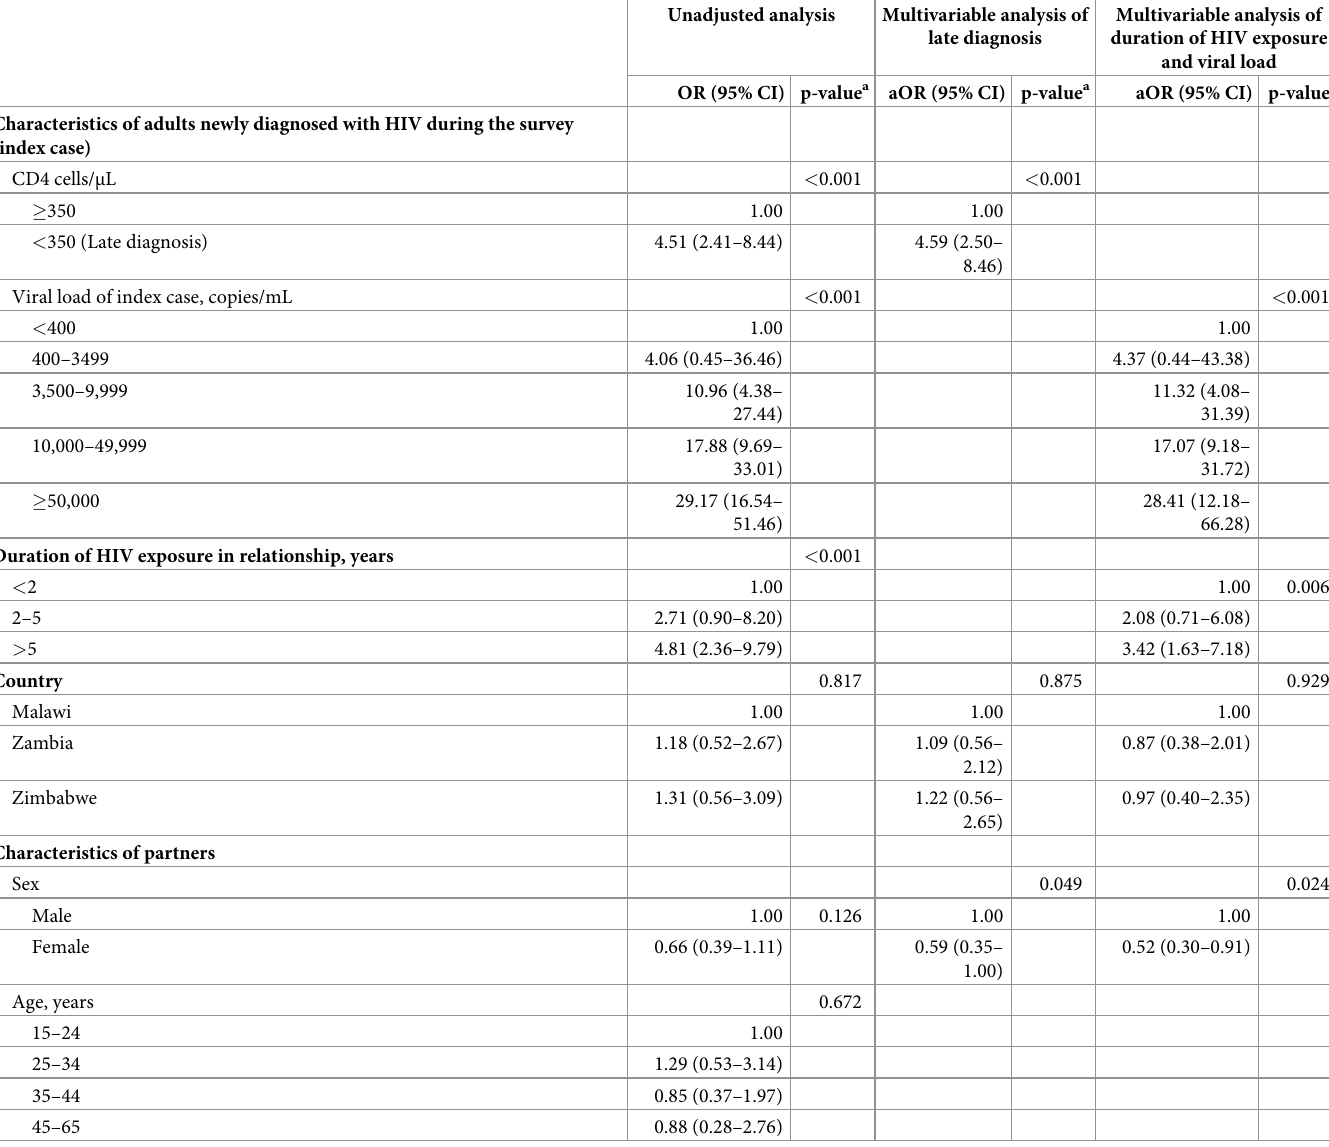
Table 5. Factors associated with HIV-positive status of exposed partners of adults newly diagnosed with HIV during the survey in Malawi, Zambia, and Zimbabwe